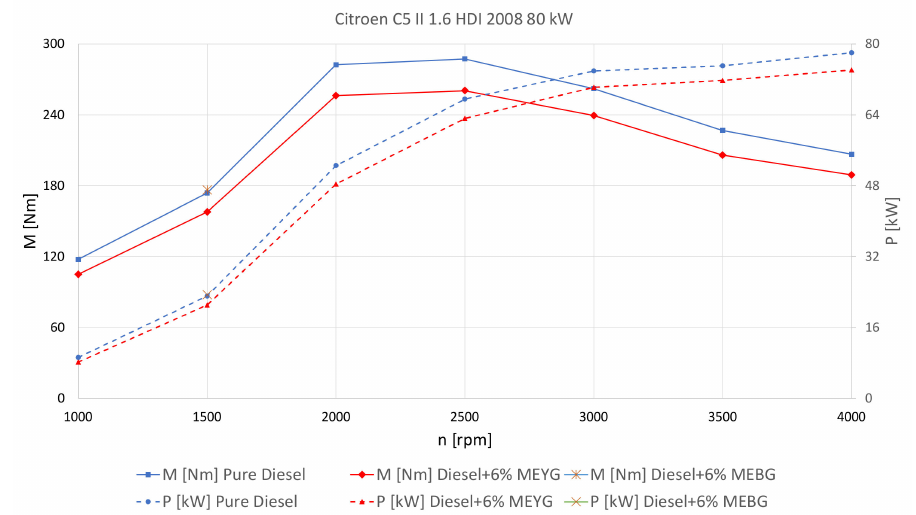
Figure 5. The engine characteristics: Torque M(n) and Power P(n) under full engine load for